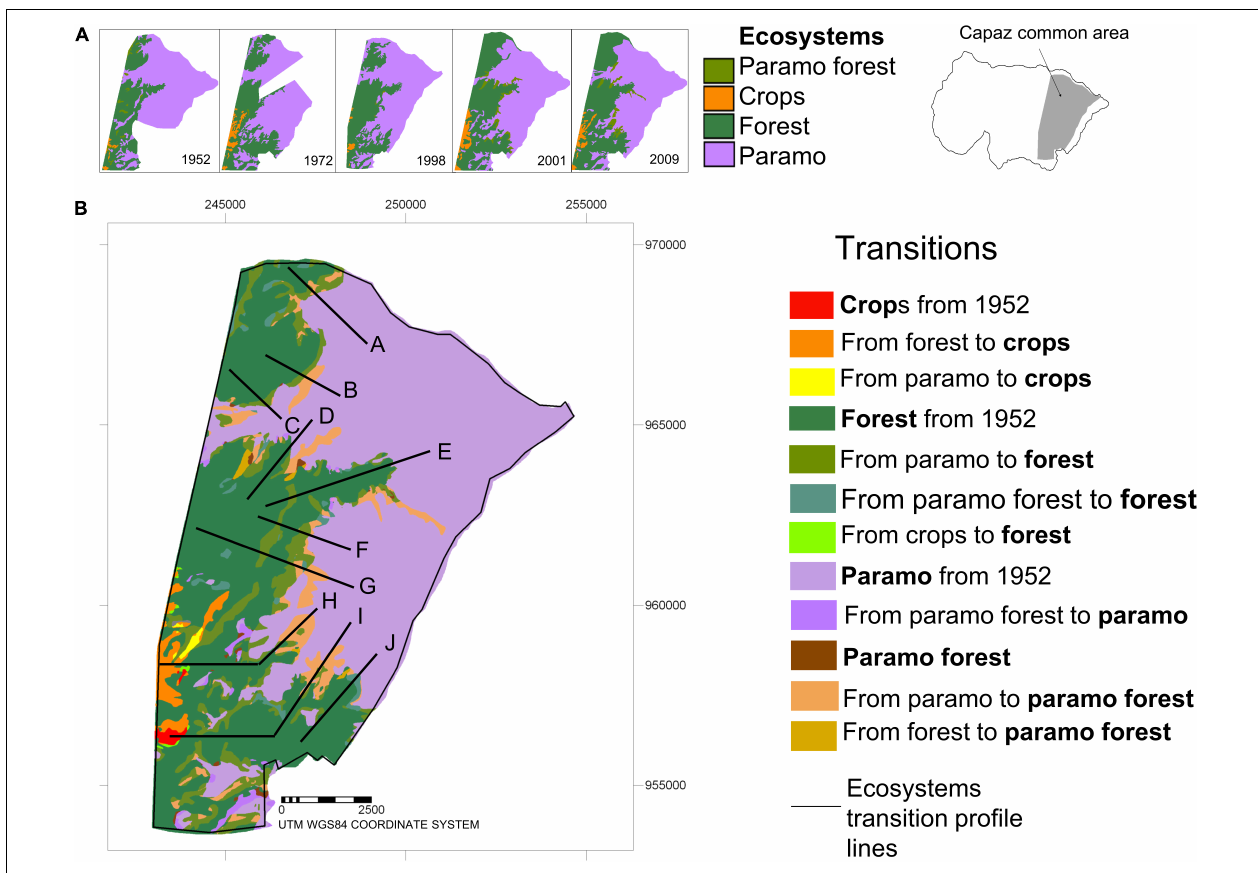
FIGURE 2 | Ecosystem and transitions maps of the Capaz study area, Cordillera de Mérida, Venezuela. (A) Ecosystem maps for the 5 years of study (years are indicated for each map). The treeline zone’s detailed area was all the ecosystems maps have the maximum coincidence is presented (Capaz common area). (B) Ecosystem transitional/change map. The major transitions are indicated. Ten lines for the different transitional sequences of change are